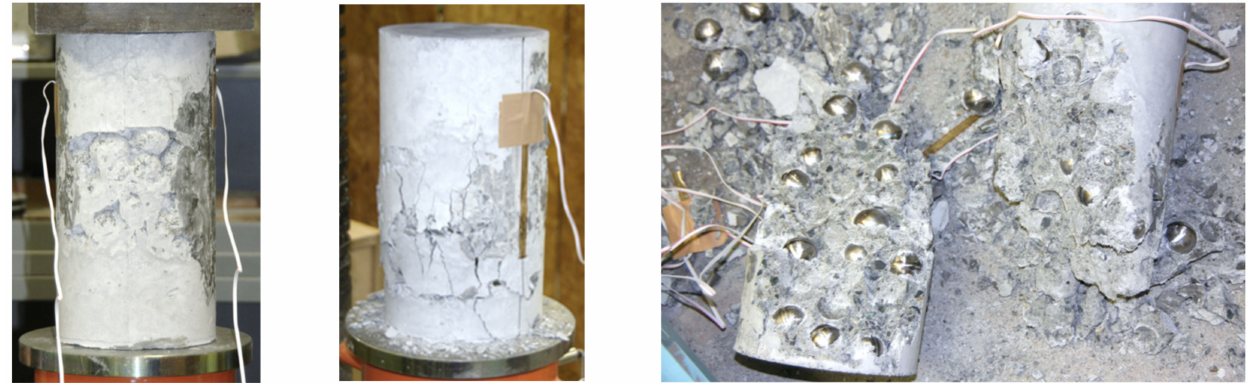
Figure 13. The failure picture of 2009 SB